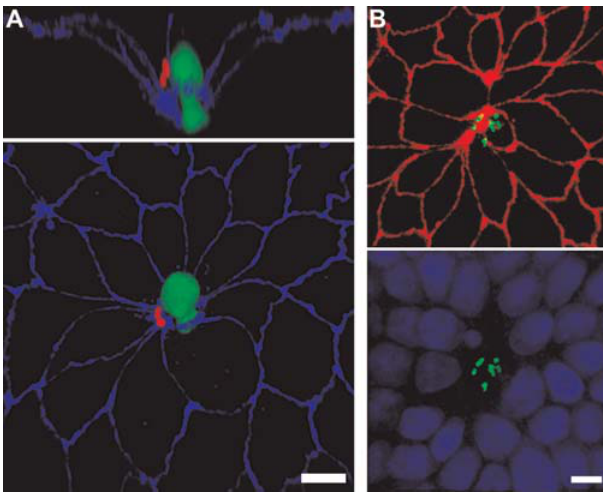
Figure 5. L. monocytogenes Adhesion to Sites of Cell Extrusion Polarized MDCK monolayers on Transwell filters were infected from the apical side with Wt L. monocytogenes for 10 min. (A) Extruding cells were stained with Sytox green prior to fixation. Antibodies to L. monocytogenes (red) were used to visualize adhered bacteria, and anti-ZO-1 (blue) antibodies were used to visualize the cell junctions. (B) Monolayers were stained with antibodies to L. monocytogenes (green) and ZO-1 (red), and with toto-3 (blue), which illustrates missing nuclei at L. monocytogenes adhesion sites. Scale bars 10 l m. DOI: 10.1371/journal.ppat.0020003.g005